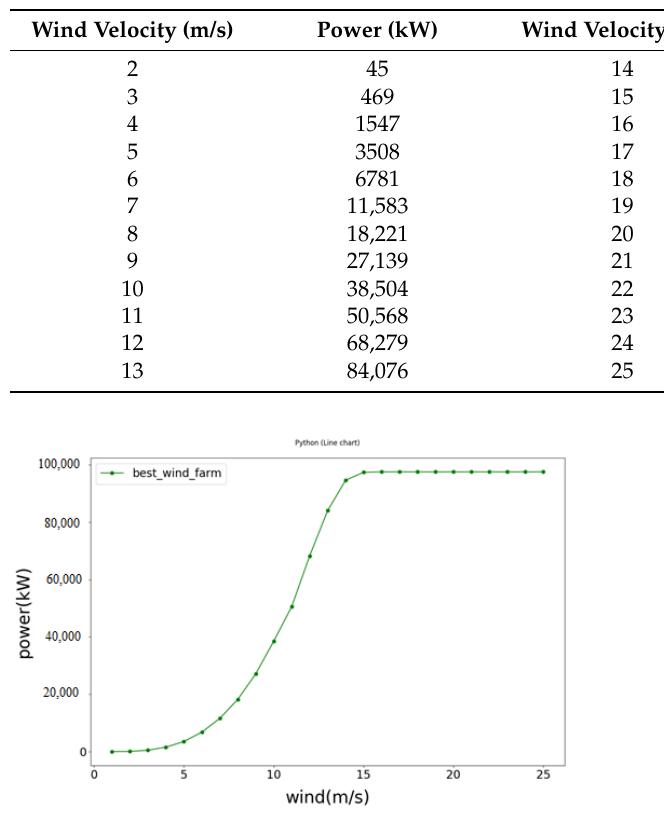
Figure 9. The optimal windfarm layout with our real SINICA dataset (8 × 8 matrix and 32 turbines). Table 4. Wind power optimization at each wind velocity.